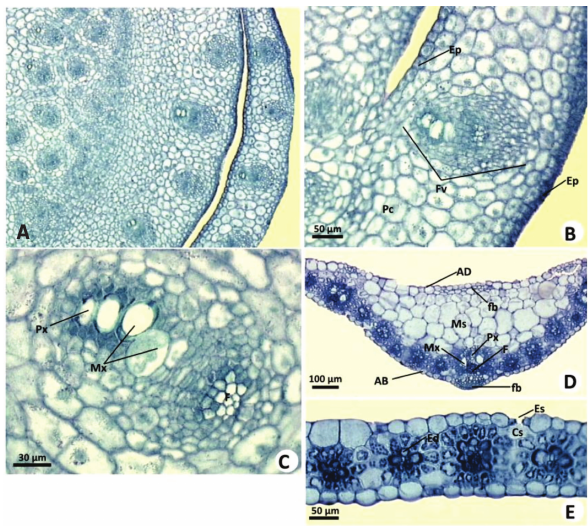
Figure 7. Transversal section of a leaf of corn grown in nutrient solution containing 300 µmol L -1